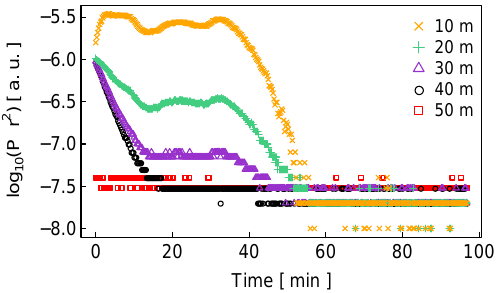
Figure 4. Logarithm of range-corrected signal reported RCS = P · r 2 in the first five range gates during a termination hood mea- surement of LUMO sensor A with firmware